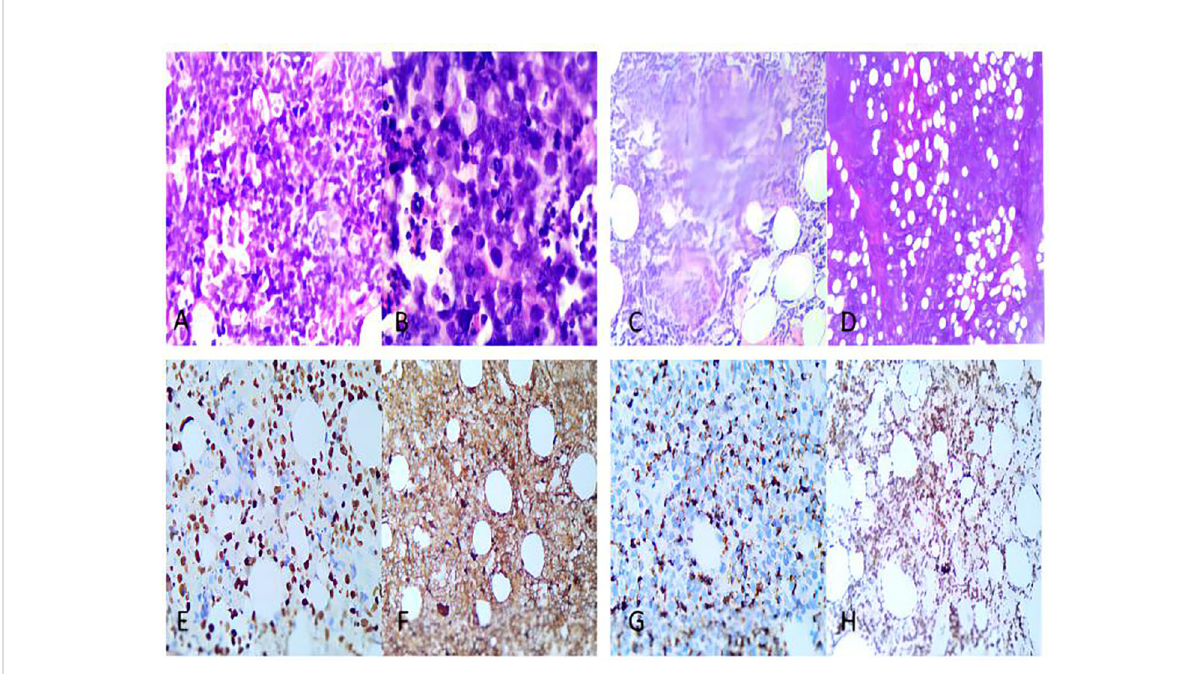
FIGURE 1 Pathological and immunohistochemical images of the patient. (A, B) . Obviously heterogeneous medium-sized tumor cells with apoptotic nuclear fragmentation. (C) . Tumor cells angiodestructive growth (D) . Subcutaneous interfatty in fi ltration with extensive necrosis. (E) . EBER positive. (F) . CD3-positive. (G) . TIA1-positive. (H) . Ki-67 positive, shows high value-added